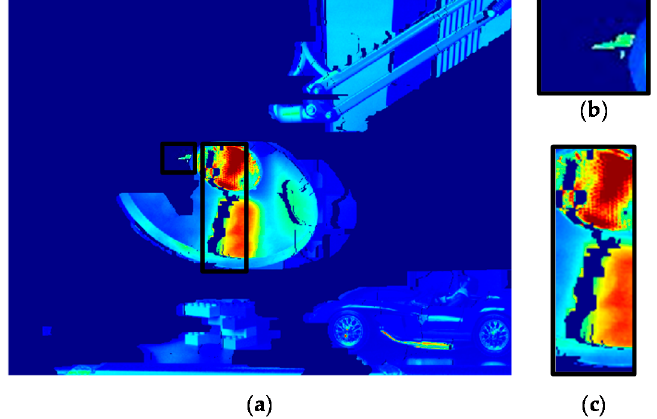
Figure 9. ( a ) R w a ; ( b ) example of incorrectly warped part enlarged with a black box in ( a ); and ( c ) example of holes enlarged with black box in ( a ).